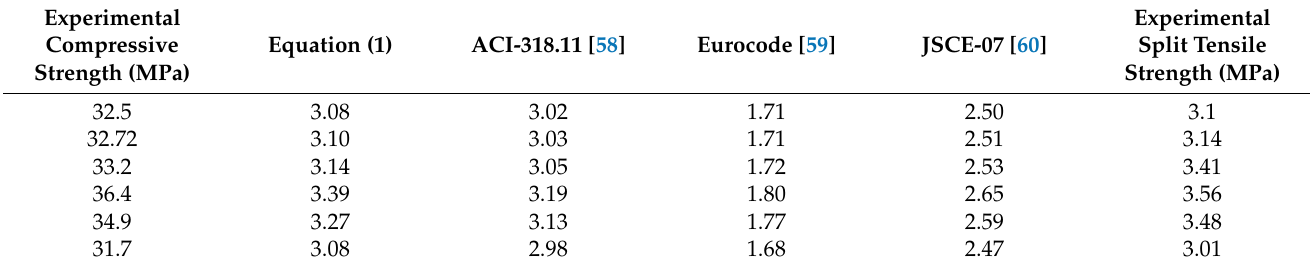
Table 3. Experimental and predicted tensile